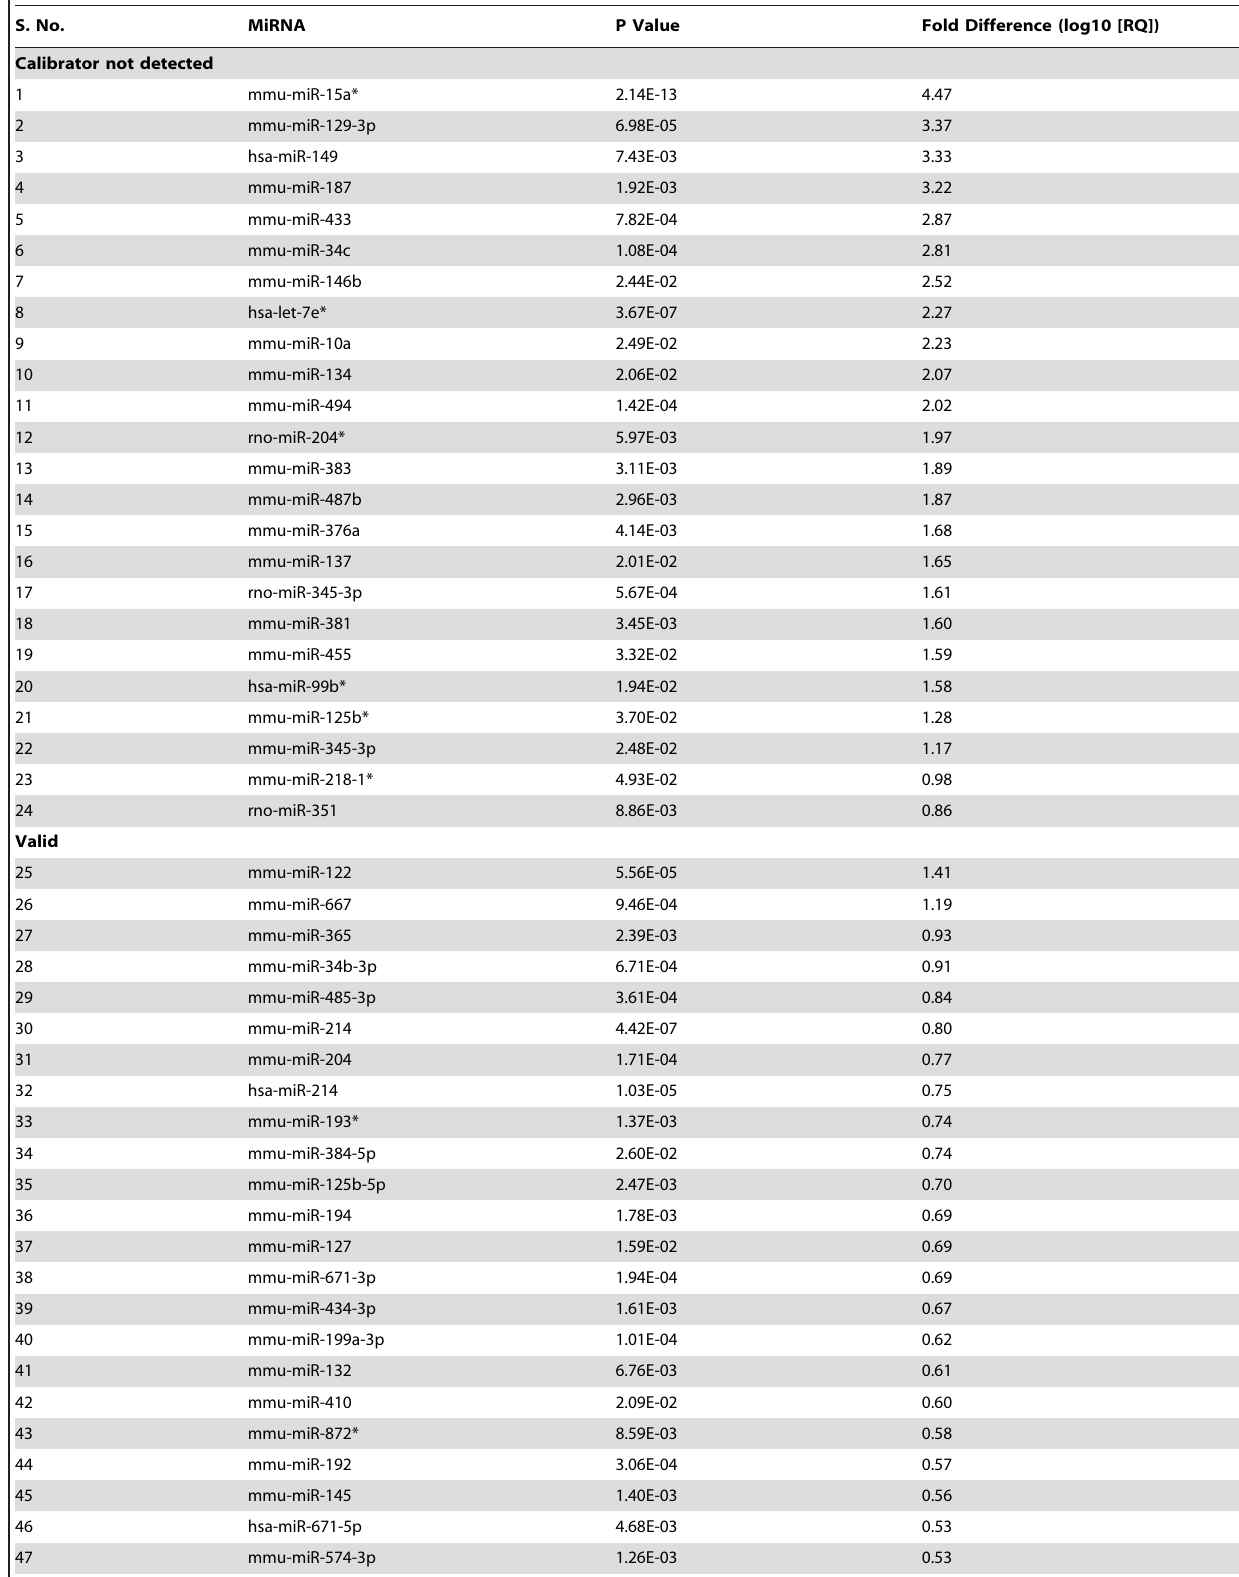
Table 4. Significantly modulated miRNA in